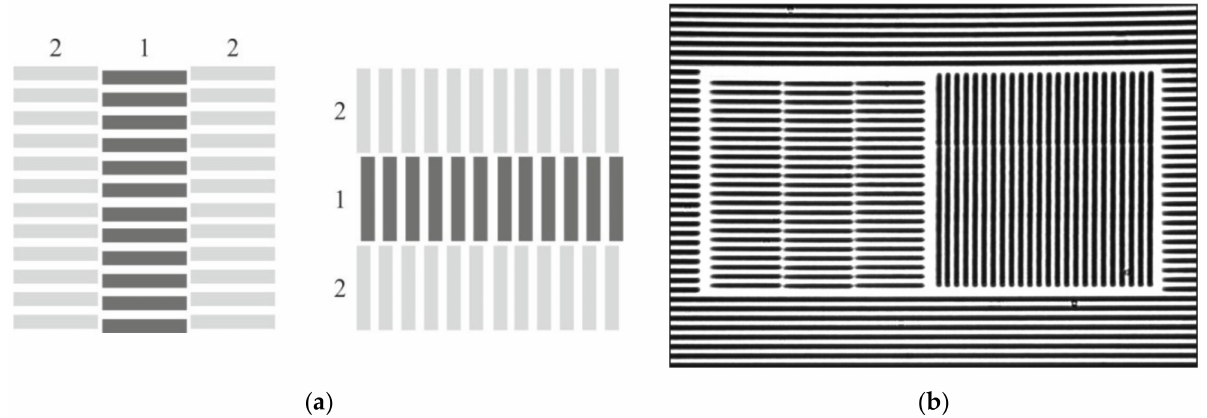
Figure 6. General configuration of two-coordinate built-in marks ( a ) and micrograph of a real mark ( b ).